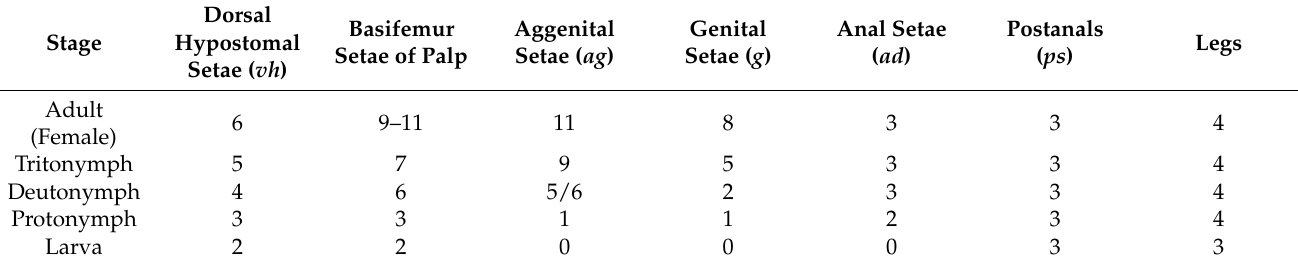
Figure 3. Bdella muscorum , female: ( A ) Leg I; ( B ) Leg II; ( C ) Leg III; ( D ) Leg IV. Table 2. Changes of leg chaetotaxy in different stages of Bdella muscorum. Table 1. Changes of chaetotaxy in different stages of Bdella muscorum